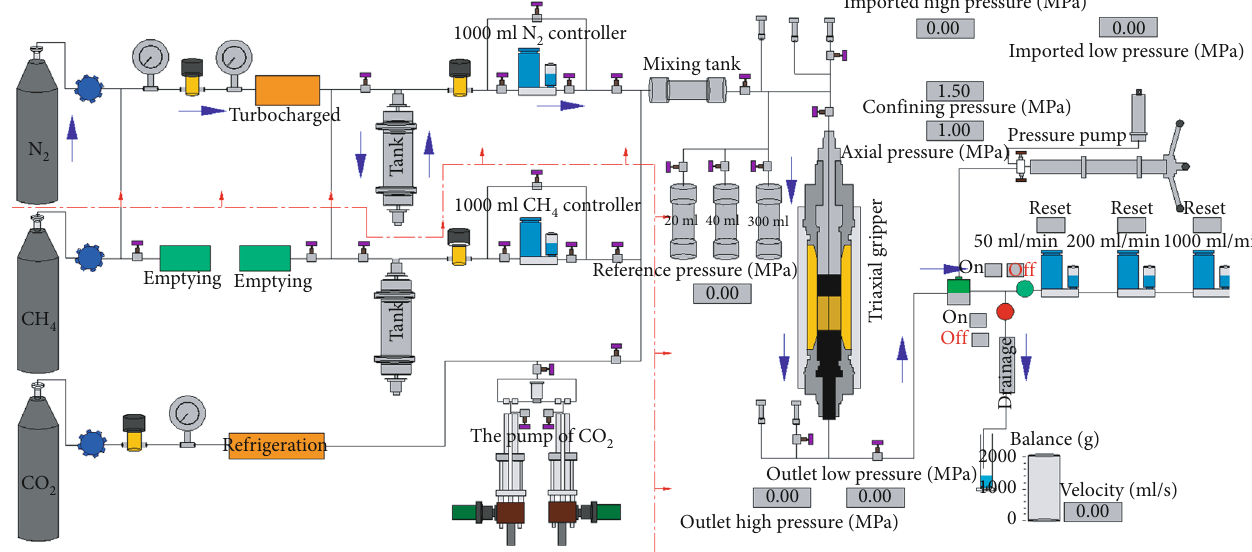
Figure 2: Test system and